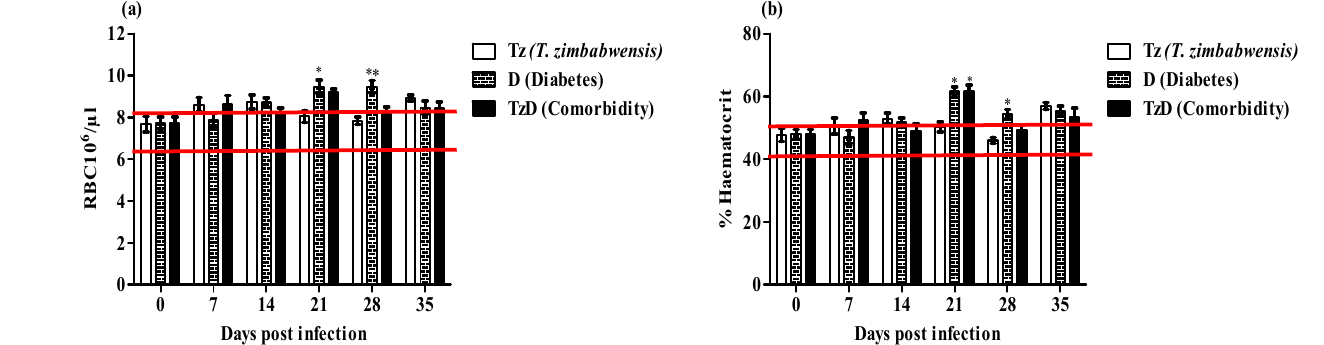
Figure 5. Red Blood Count (RBC) concentration ( a ) (± SEM) and haematocrit ( b ) (± SEM) in male Sprague Dawley rats comorbid with type 2 diabetes mellitus and Trichinella zimbabwensis . Sprague Dawley rats were infected with Trichinella zimbabwensis (Tz); with induced type 2 diabetes (D) and co-morbid with Trichinella zimbabwensis and type 2 diabetes (TzD). Horizontal red lines depict the range of reference values for RBC (6.39–8.01) and haematocrit (42–49) in male Sprague Dawley rats (He et al.) [27]. Values are presented as means and vertical bars indicate SEM ( n = 6 in each group) and asterisks represent significant differences between the groups (* p < 0.05, ** p < 0.01).